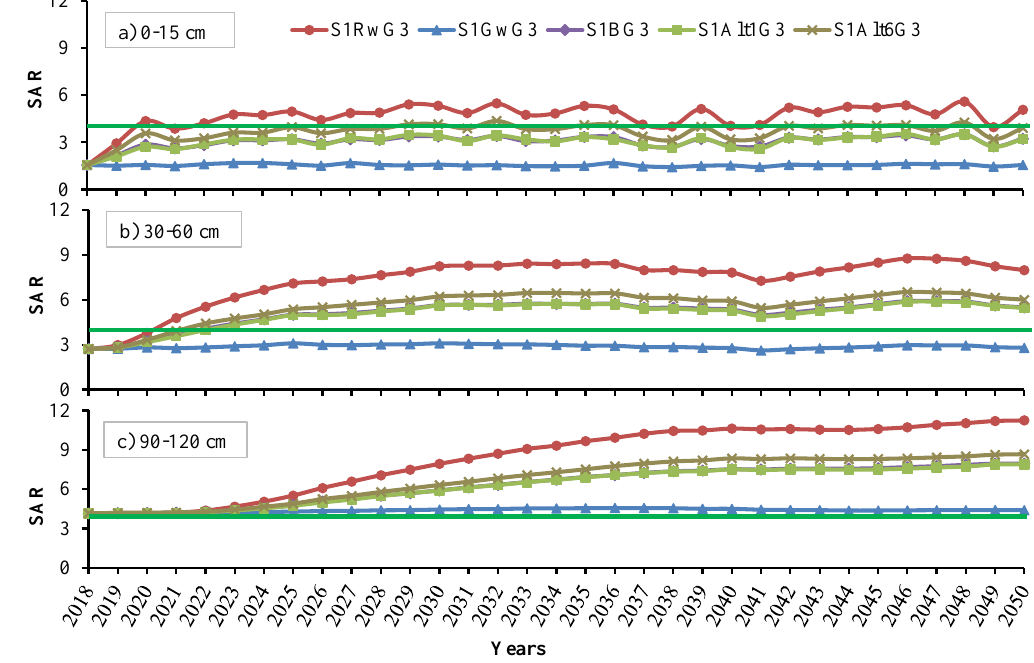
Figure 3. Impact of different water qualities (recycled water, RW; good water, GW; blending RW and GW in a 1:1 ratio, B; RW and GW used in monthly cycles, Alt1; and RW and GW used in half-yearly cycles, Alt6) and annual gypsum applications of 8.6 t/ha (G3) on annual SAR for calcareous soil (S1) under wine grape cultivation.